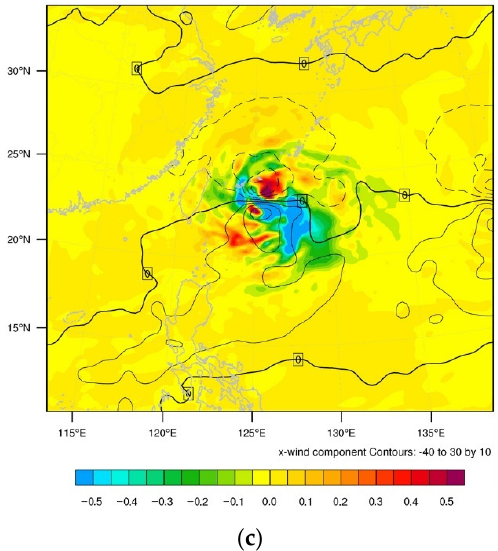
Figure 9. Analysis increments at 500 hPa of ( a ) water vapor mixing ration (shaded; kg/kg), ( b ) temperature (shaded; K), and ( c ) x-component of wind (shaded; m/s) of the single GEOMS radiance observation test. The black solid lines represent the corresponding background variables, respectively, at analysis time 0600 UTC 8 August.